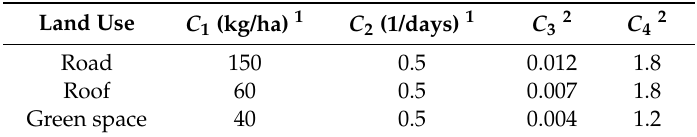
Table 3. Calibrated SWMM model parameters for TSS